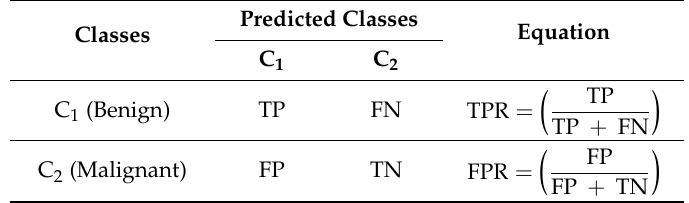
Table 4. Validation assessment measures.